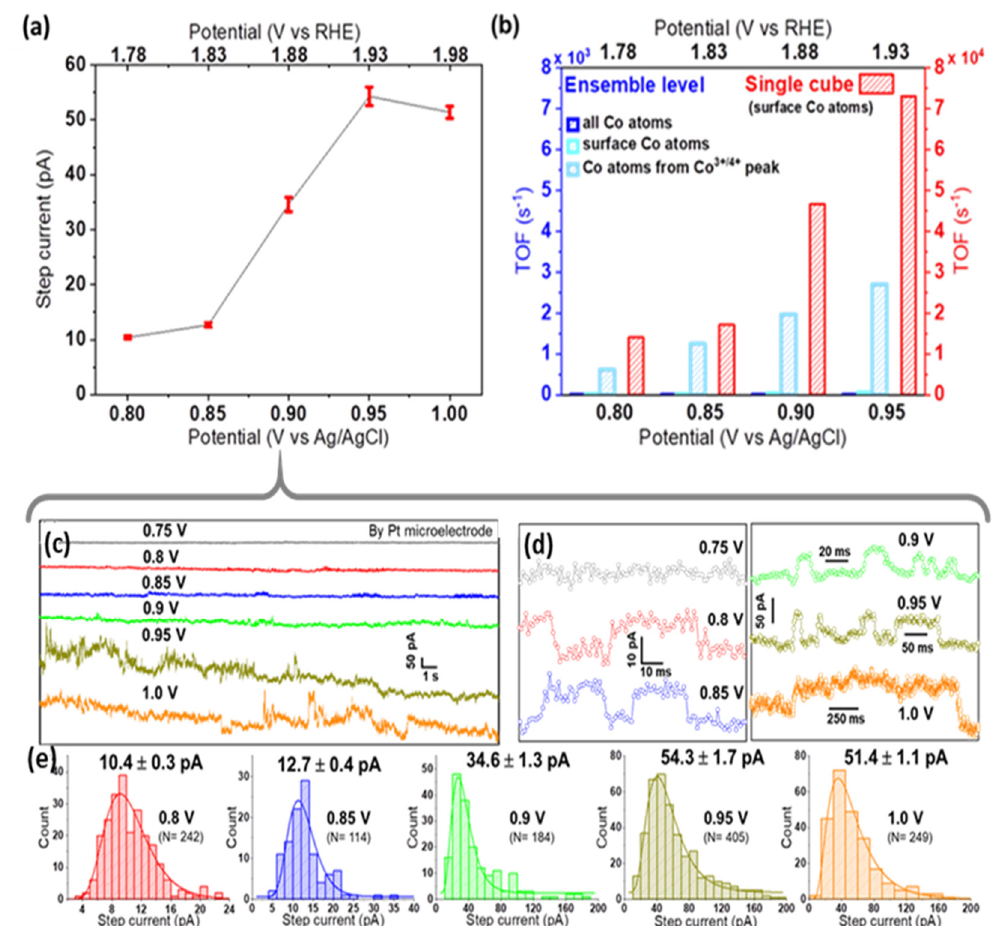
Figure 4. ( a ) Current–potential response in nano-impact experiments, showing the mean ± std. error of the mean step current, ( b ) TOF comparison for Co 3 O 4 cubes probed at ensemble vs. single cube level. For calculations at the ensemble level, either all Co atoms, surface Co atoms, or Co atoms contributing to the Co 3+/4+ oxidation peak of the LSV (peak prior to OER ‘onset’) were considered as active sites of 2.8 μ g cm − 2 nanocubes drop-cast on a Pt RDE. Note the 10-times larger scale for single cubes; representative chronoamperograms ( c ) and enlarged impact signals ( d ) recorded at different potentials (offset vertically for better comparison), and ( e ) the obtained step-current histograms used for plot ( a ).